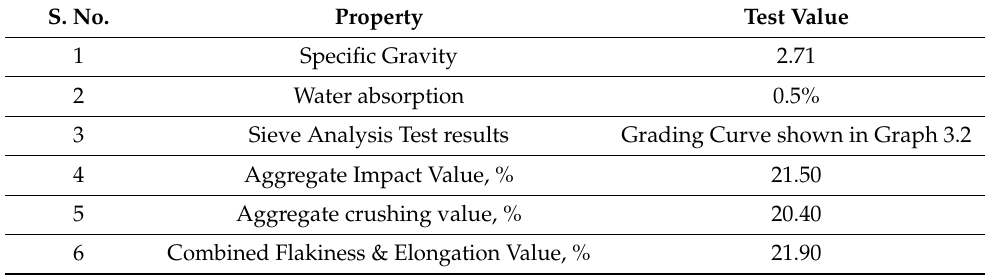
Table 2. Properties of coarse